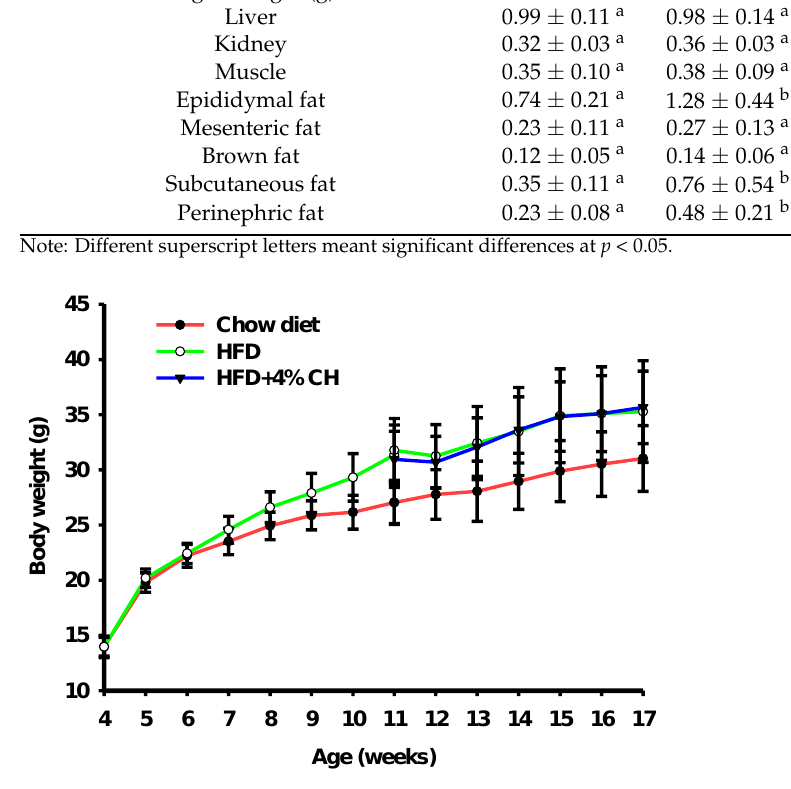
Figure 2. The effects of CH supplementation on the body weight change of obese mice induced by HFD.